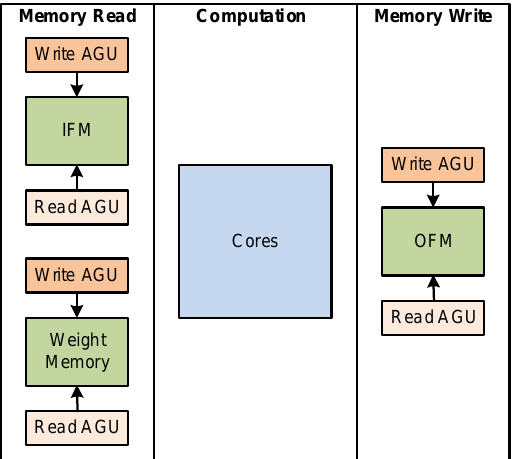
Figure 3. Dataflow execution of the